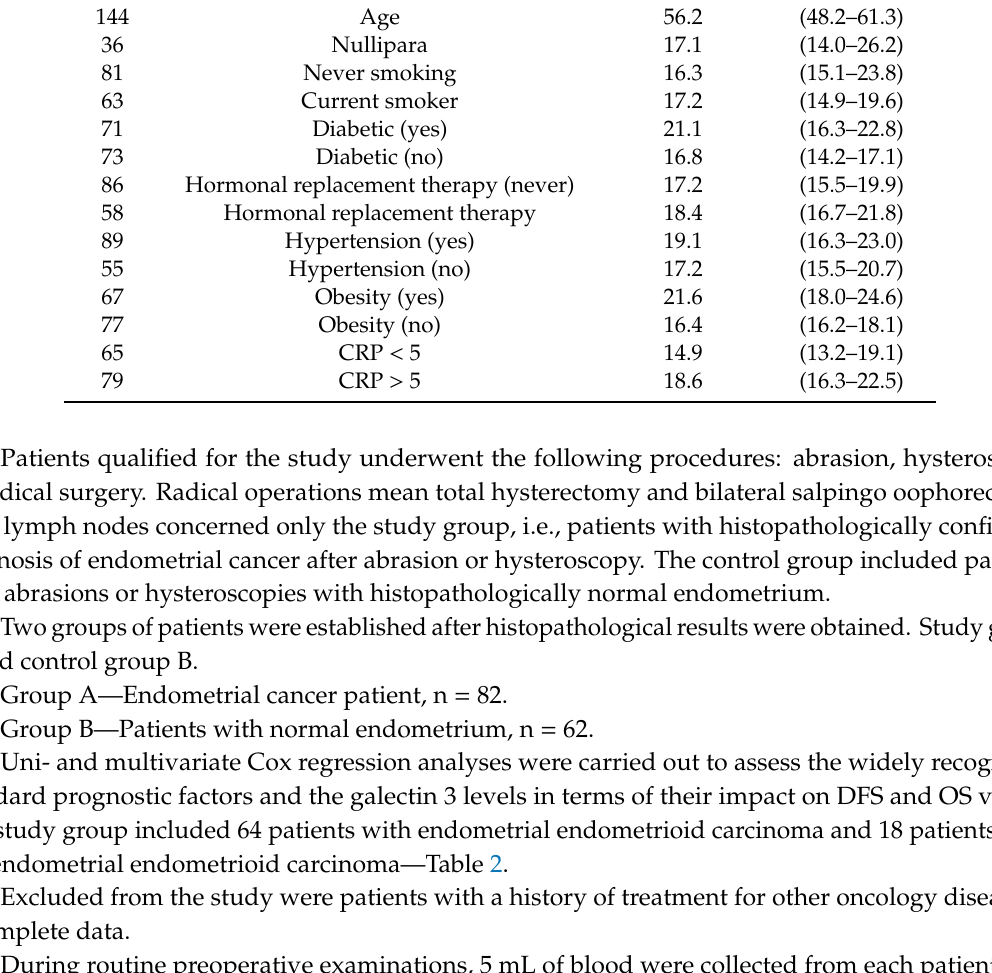
Table 1. Serum galectin 3 levels in patients with risk factors for endometrial cancer.